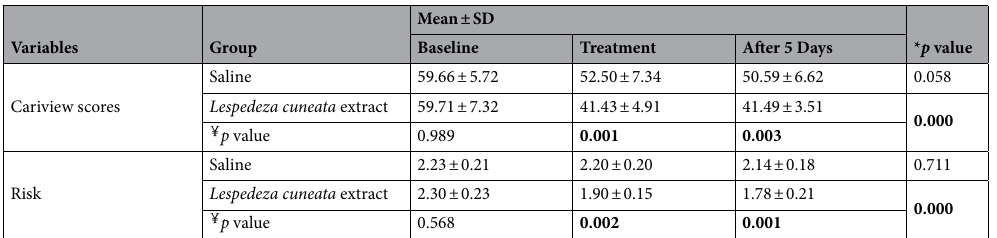
Table 3. Changes in the Cariview scores of the two groups. ￥ p values are determined by independent t test, * p values are determined by one-way ANOVA and Tukey tests ( p < 0.05).; Values are means ± standard deviations.; significant (bold); 0.0–40.0, low risk; 41.0–70.0, medium risk; 71.0–100.0, high risk; 1, low-risk; 2, medium- risk; and 3,